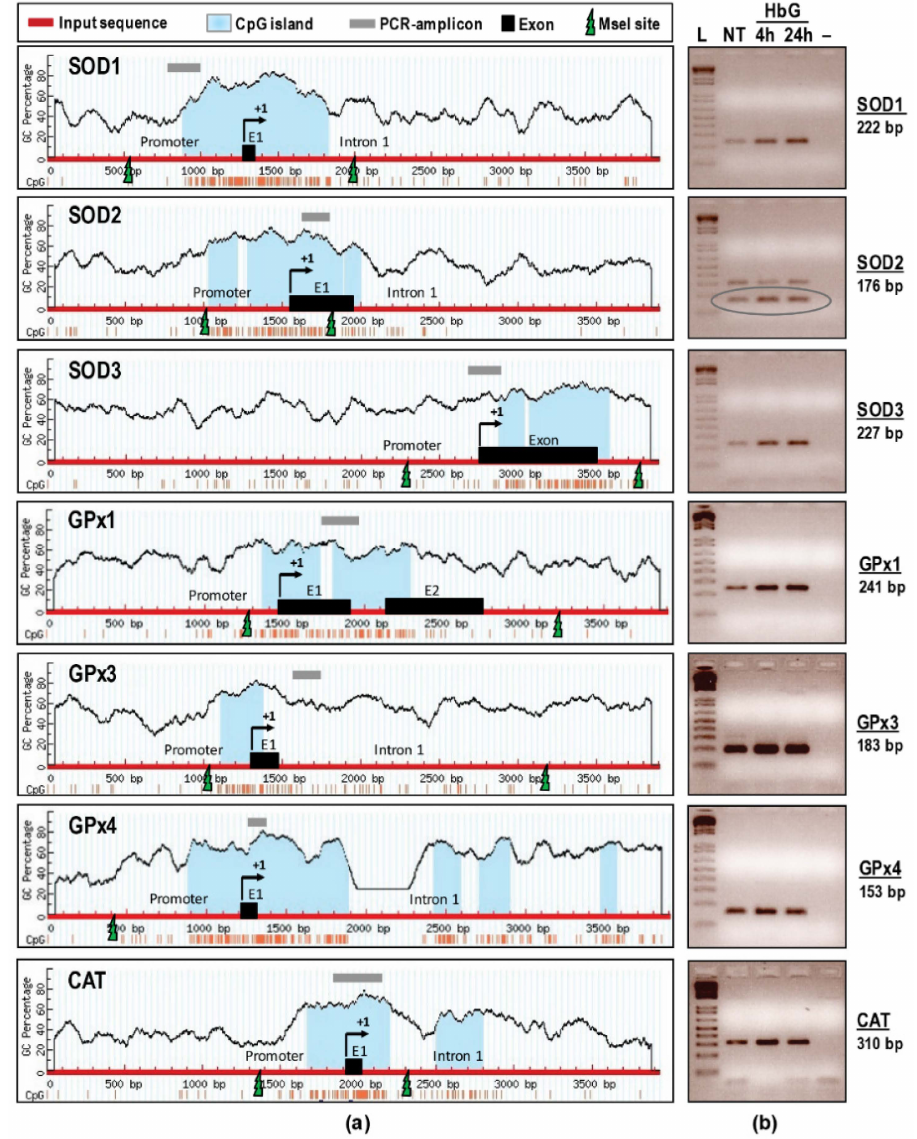
Figure 4. DNA methylation status of SOD1-3, GPx1, GPx3, GPx4, and CAT following HbG infusion. ( a ) CpG island search and restriction mapping. Four kb genomic regions (thick red line) harboring putative promoter, exon 1, and intronic regions of SOD1-3, GPx1, GPx3, GPx4, and CAT were subjected to sequence analysis. Located CpG islands indicated in light blue, PCR amplicons in grey line, exons (E1-E2) in black boxes, MseI restriction sites in green lightning bolts, and TIS labelled as +1. Vertical lines depict GC percentage; ( b ) Agarose gel images (inverted) of hypermethylated SOD1-3, GPx1, GPx3, GPx4, and CAT following HbG infusion. The expected sizes (in bp) of PCR amplicons listed on the right. L: Ladder (1 Kb Plus), NT: non-treatment group, HbG (4 h or 24 h): oxyglobin-infused groups at different time points. “ ´ “: Template-less negative control. The SOD2 resulted in two distinct amplicons (approximately 176 bp and 310 bp), however the lower band with predominant intensity is the expected one